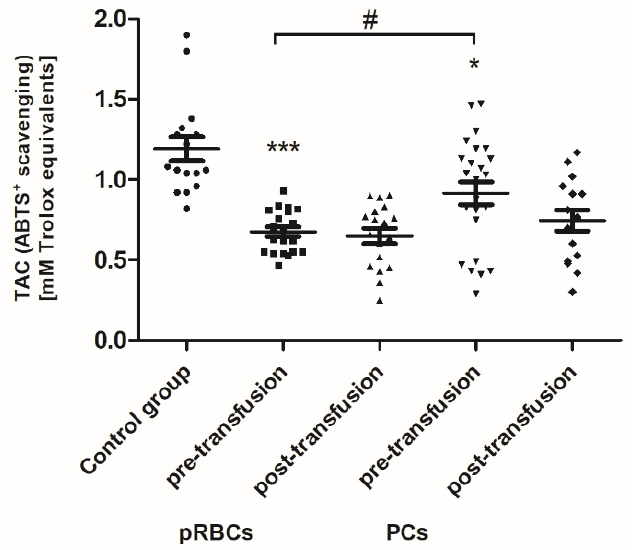
Figure 6. The TAC of plasma in healthy volunteers (control group) and AML patients before and after transfusion of the blood component. Scatter plots show all of the data values obtained. Data are presented as mean ± SE. * p < 0.05, *** p < 0.001 compared to the control group; # p < 0.05 compared pre-transfusion pRBCs versus PCs; statistically significant according to the Tukey test. pRBCs—packed red blood cells; PCs—platelet concentrates.